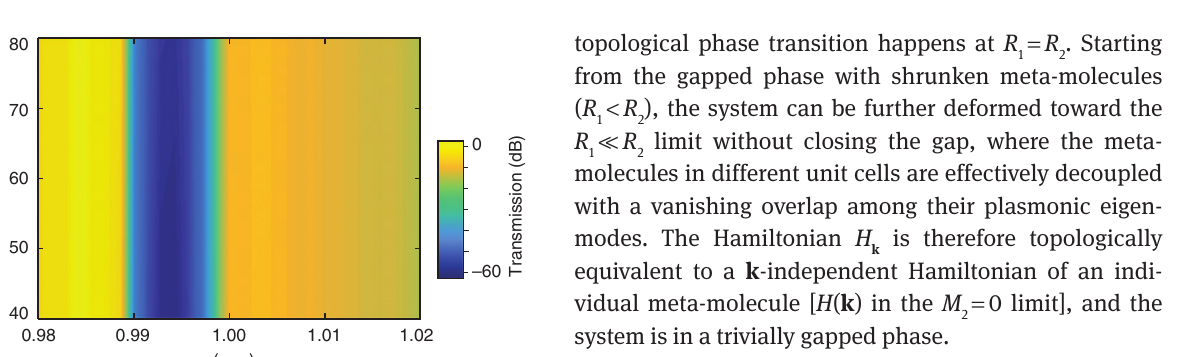
Figure 2: Bulk band structures and band inversion. Bulk band structure of the unit cells for various values of t calculated using the tight-binding method, and their corresponding lattices. > 3 or t < 1; the band structure is gapped. (B) a / R = 3 or t = 1; a plasmonic double Dirac cone is formed at Γ . The 3D band structure (A) a / R 1 1 > R showing the Dirac cones is shown in the inset. (C) R or t > 1. A band gap is opened in the shrunken and expanded cases with t ≠ 1 [(B) 1 2 and (C)]. The yellow area shows the band gap and the lowest and highest frequency bands are shown as dashed lines. The bands are inverted around Γ in (C) compared to (A), signaling a topological phase transition. (D–F) Corresponding lattice structures with the nearest- neighbor interaction strengths shown schematically by lines between the